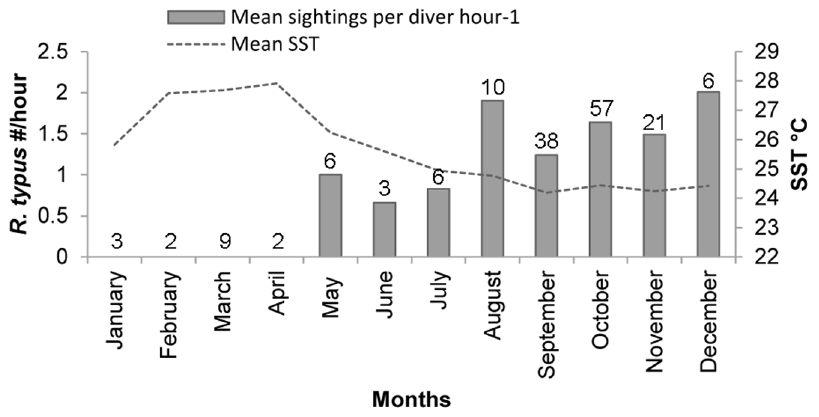
Fig. 2. Monthly distribution of R. typus at Darwin Island. Plot showing whale shark sightings per diver hour 2 1 (left axis, grey bars) with mean Sea Surface Temperature (SST; right axis, grey dotted line) at Darwin Island, Galapagos Marine Reserve, between 2007–2013. Values over columns indicate the sampling effort (i.e., number of surveys) for each month.